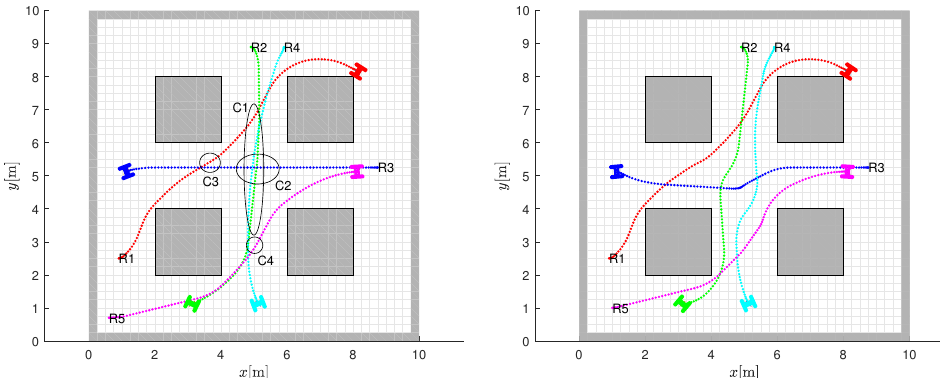
Figure 11. Coordinated collision avoidance. Obtained robot path without using collision avoidance in MPC (where robots drive over each other), with collision cases marked by ellipses (left image). Collision avoidance with prediction horizon h = 20 finds safe routes with similar travel times (right image).